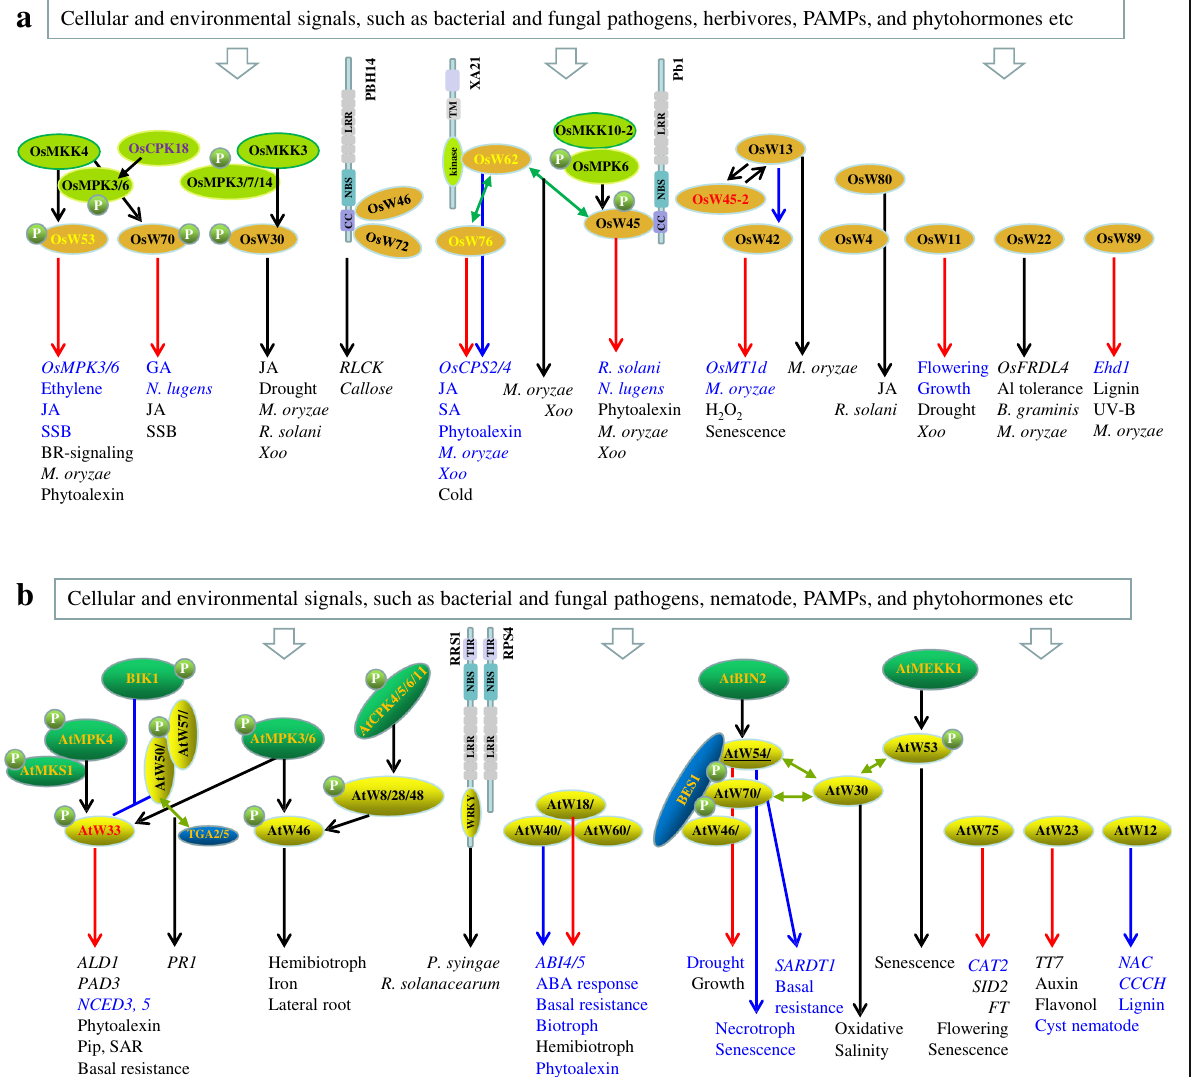
Fig. 3 Rice ( a ) and Arabidopsis ( b ) WRKY regulation in multiple pathways. OsWRKY and AtWRKY transcription factors (TFs) participate in response to various cellular and environmental stimuli. WRKY TFs may be activated by protein kinases and interaction with receptor-(like) proteins. Interaction among WRKY proteins or with other TFs, and the existence of WRKY cascade complicate WRKY regulatory network. For the details see the main text. Arrow in black for positive, blue for negative, and red for both positive and negative regulations; double arrow heads in green for interaction; WRKY in red for feedback positive and yellow for feedback negative regulations; word in blue for negatively